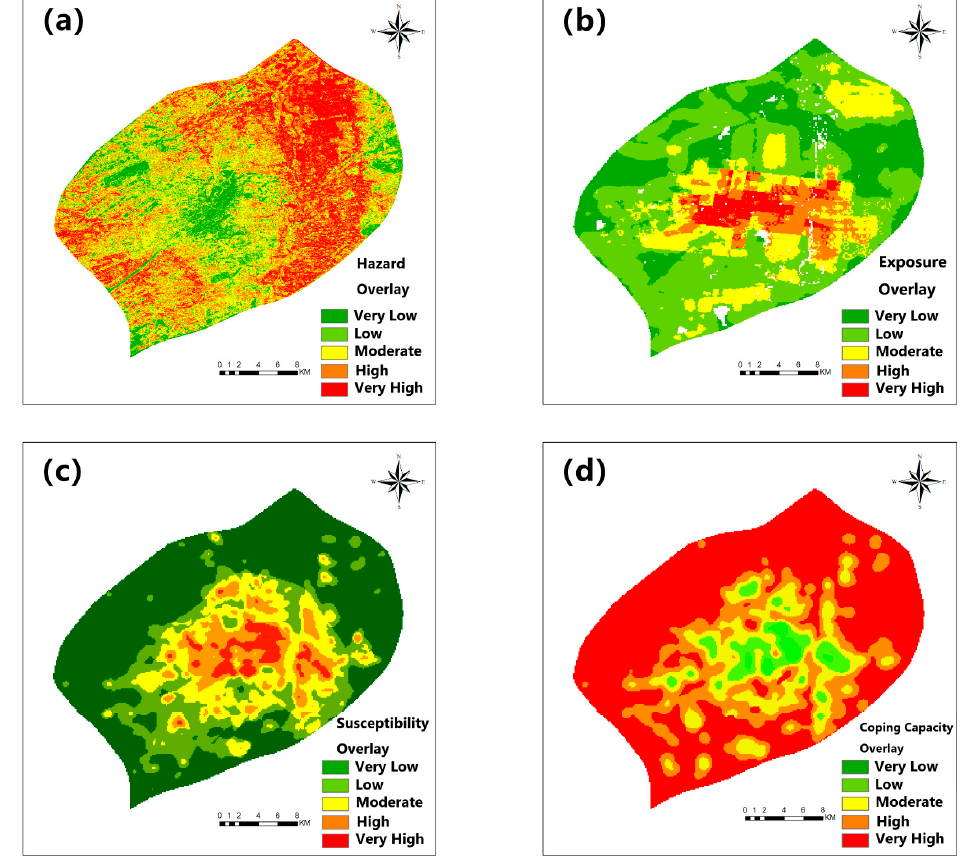
Figure 7. Hazard ( a ); exposure ( b ); vulnerability ( c ); emergency response and recovery capability ( d ).